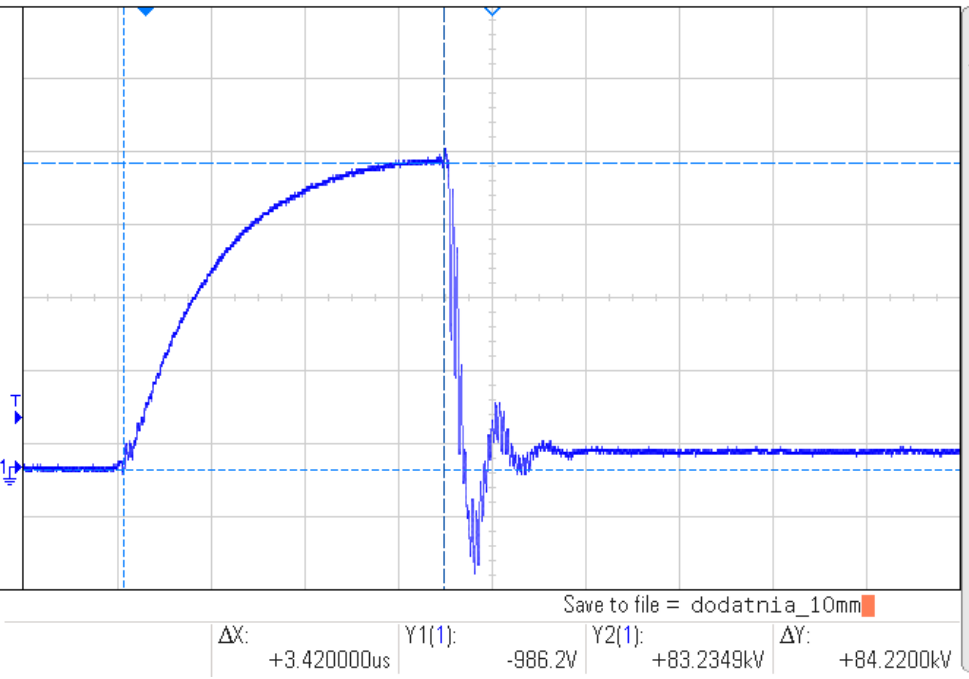
Figure 7. Waveform of voltage as a result of applying a lightning impulse voltage of negative polarity to the MCA for the length of the 20 mm spark